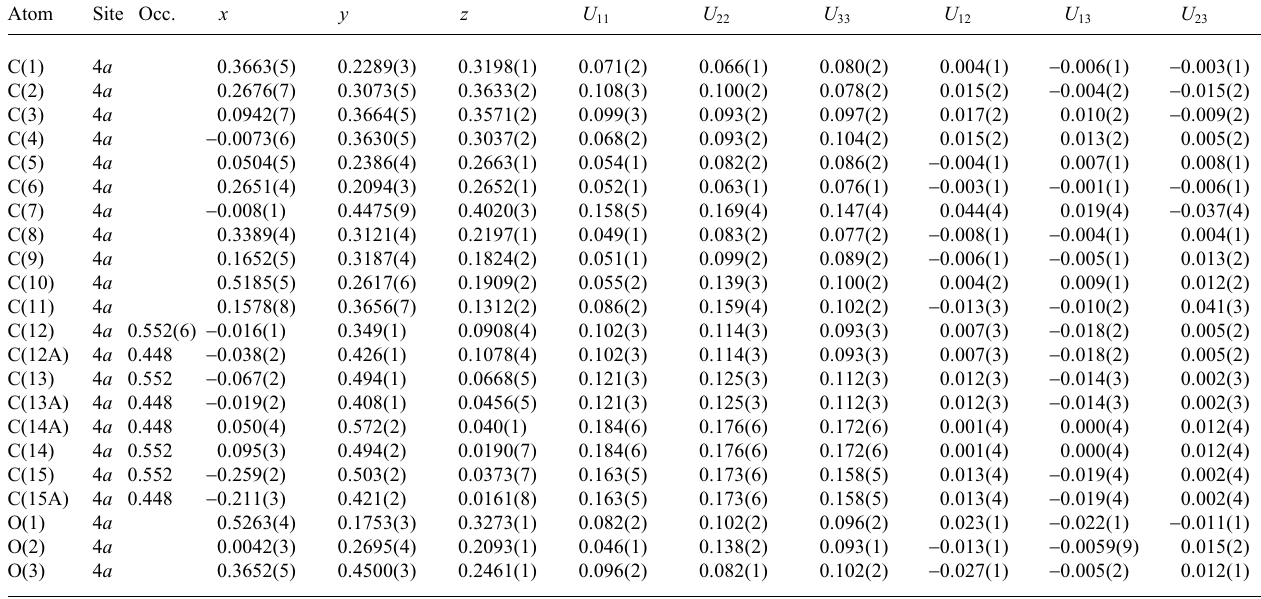
Table 3. Atomic coordinates and displacement parameters (in Å 2 ).